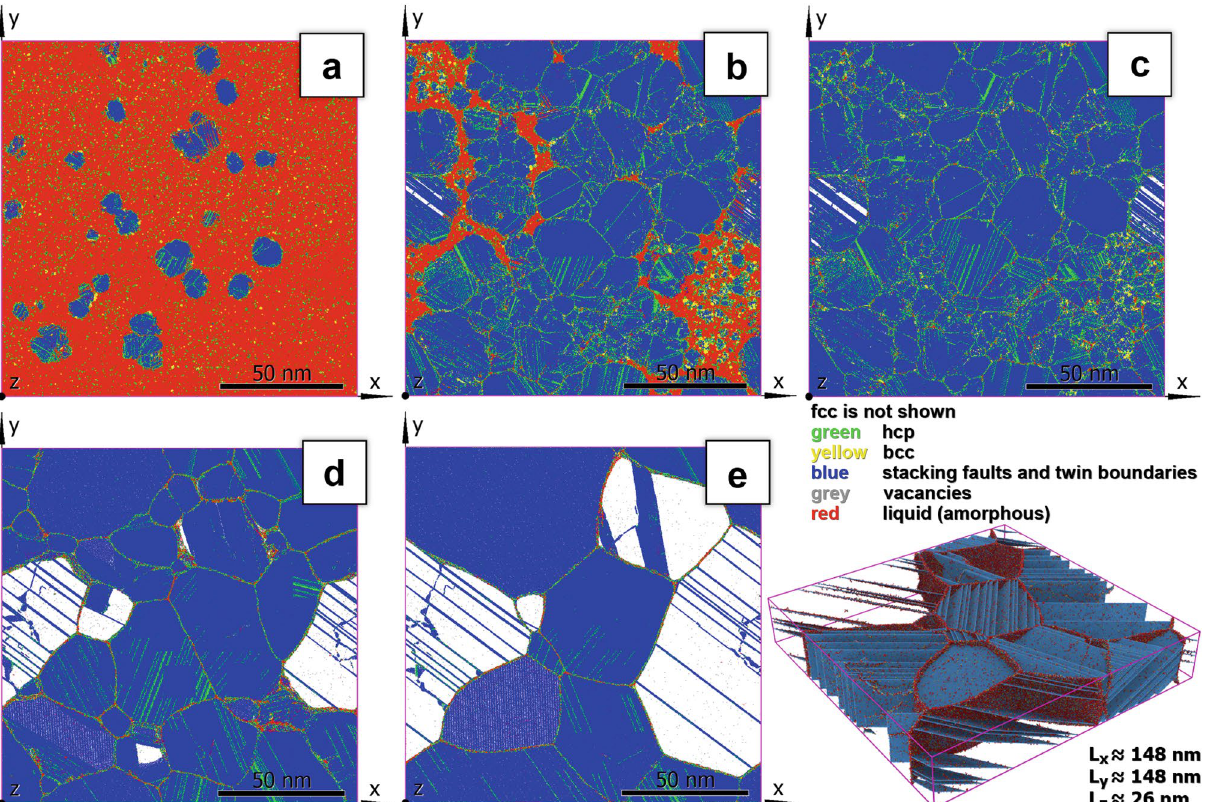
Figure 2. Nanocrystalline samples generated by crystallization from melt (M-samples). ( a – e ) Snapshots of the system structure at different stages: ( a ) The very beginning of fcc crystal nucleation in the liquid (the temperature of the sample at this instance is T = 900 K ≈ 0.678 T m ), ( b ) Crystallization is almost completed— the liquid crystallized in a very fine-grained polycrystal (after this instance the temperature of the sample gradually increase to T = 1200 K ≈ 0.904 T m ), ( c – e ) Illustration of grain coarsening during annealing at T = 0.904 T m (time interval 0–12 ns). No fcc structure atoms are shown. On the lower right, the isometric 3D view of the sample from ( e ) is